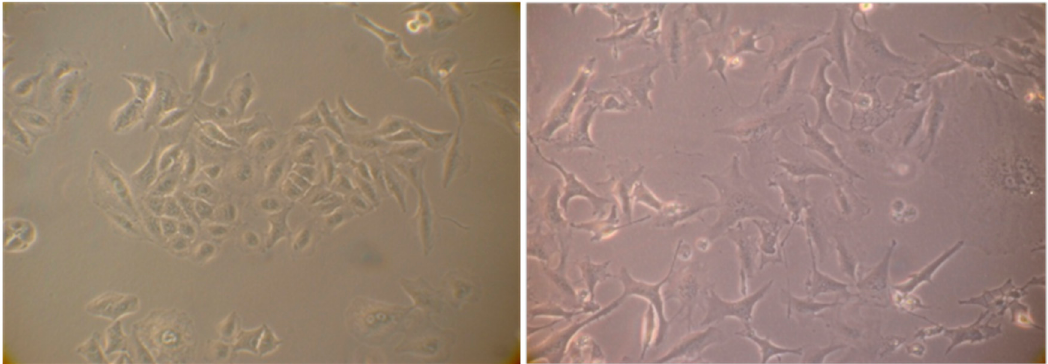
Figure 11. ( left ) Normal proliferating A549 cells; and ( right ) senescent A549 cells 72 h after treatment with the extract. Note the volume increase of cells, the cytoplasm flattening and the presence of numerous vacuoles.